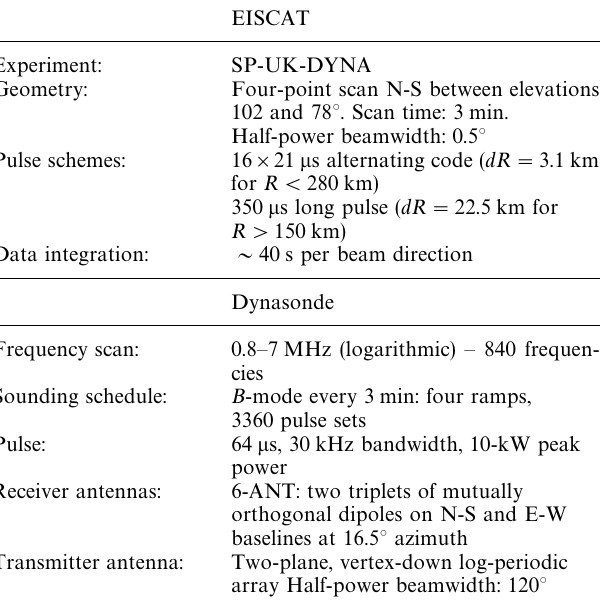
Table 1. EISCAT and Dynasonde configurations for the Special Programme, SP-UK-DYNA